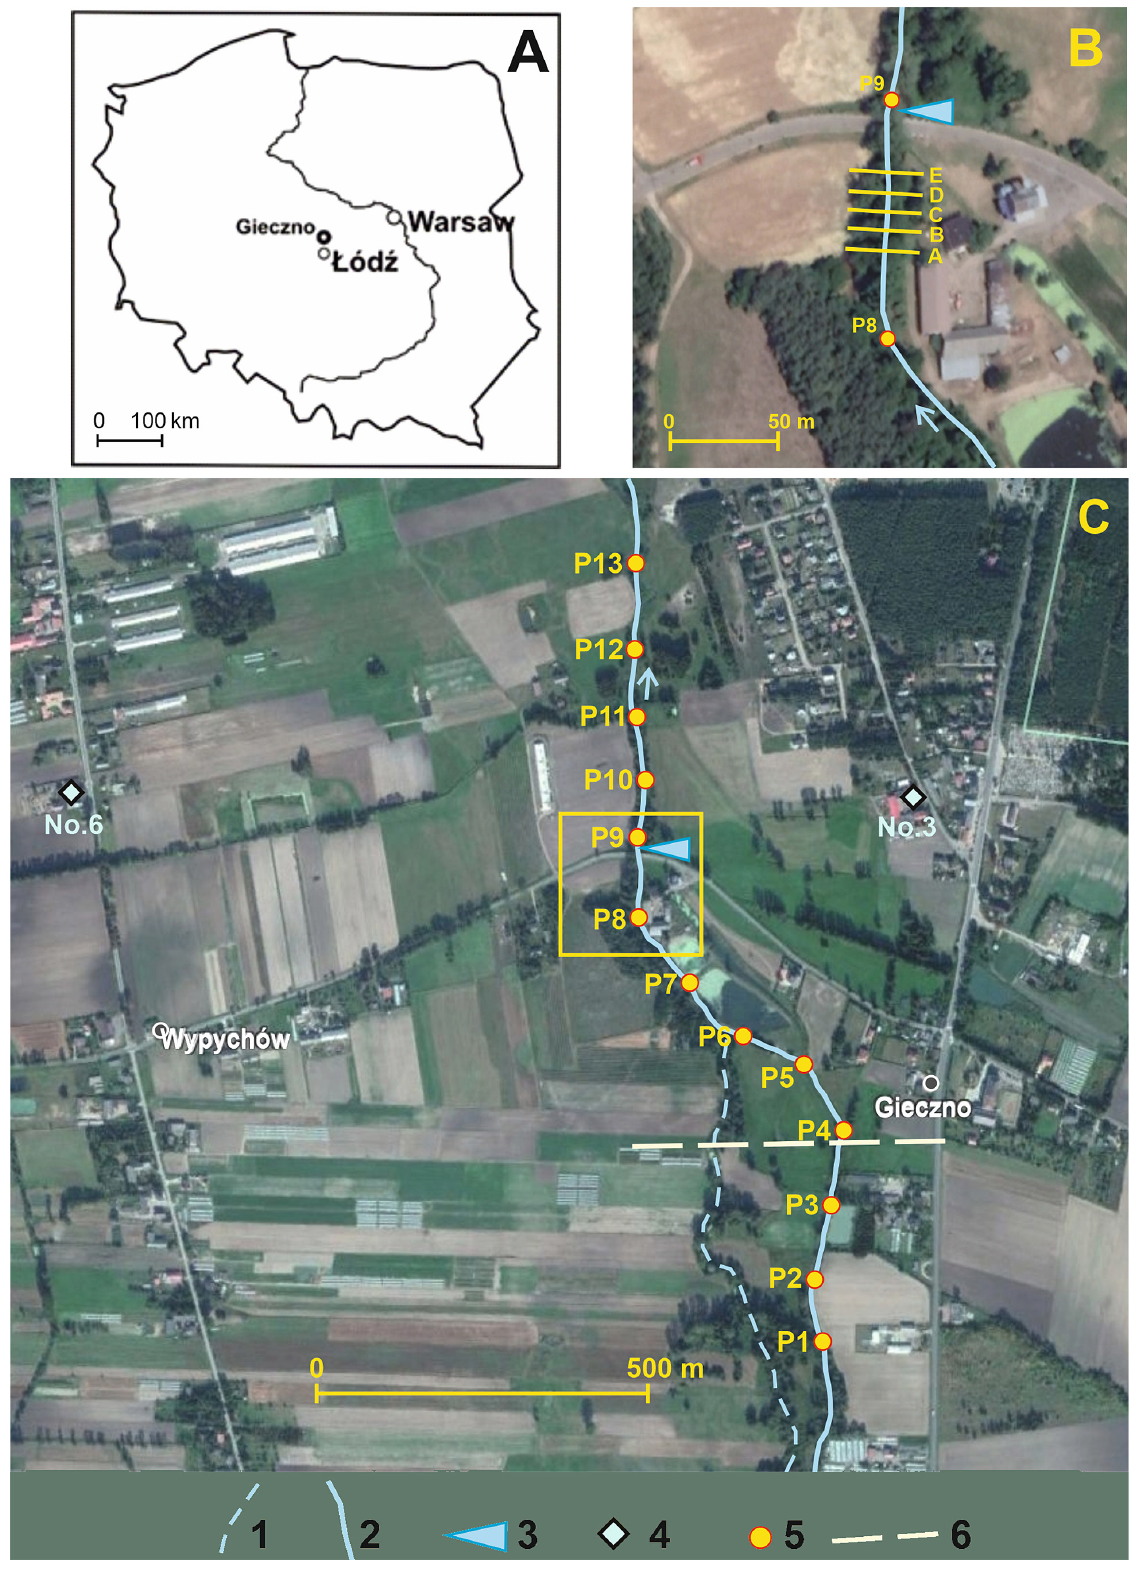
Fig. 1. Location of measuring